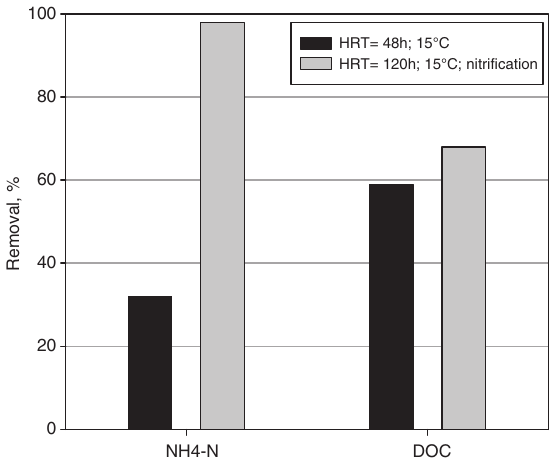
Fig. 3. Aerobic microbial degradability of water contami- nants from a depth of 24 m of the wastewater disposal pond in a fermenter of continuous mode in dependence on the hydraulic retention time (HRT) at 15 8 C